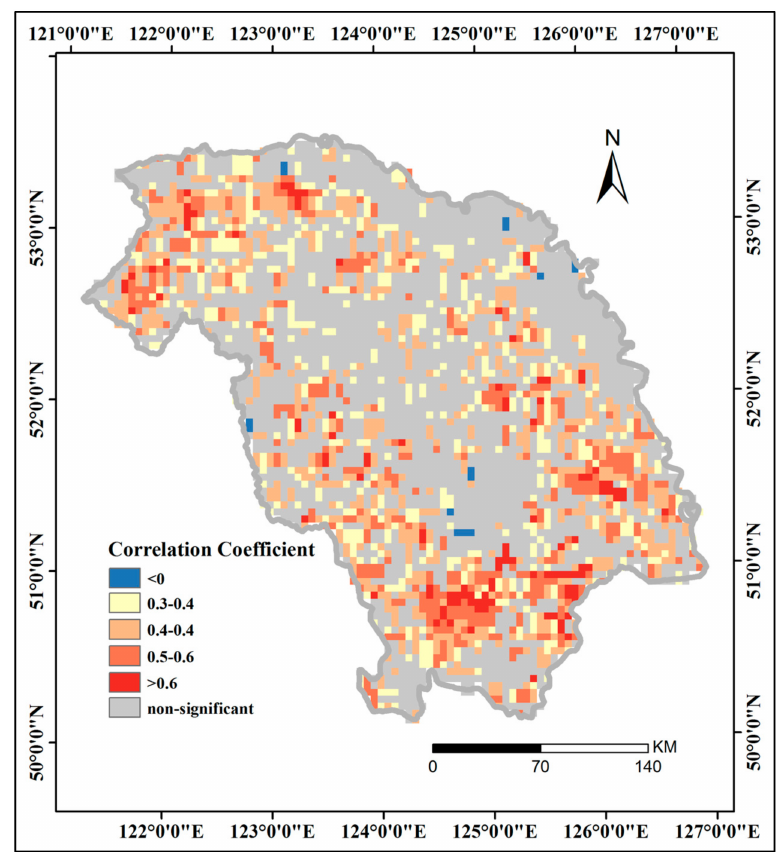
Figure 9. Correlation coefficient between Fraction of Photosynthetically Active Radiation (FPAR) and AGG in the GKM during 1982–2014. (Yellow and red indicate significant positive correlation (r > 0, p < 0.05), blue indicates significant negative correlation (r < 0, p < 0.05), and gray indicates non-significant correlation ( p >